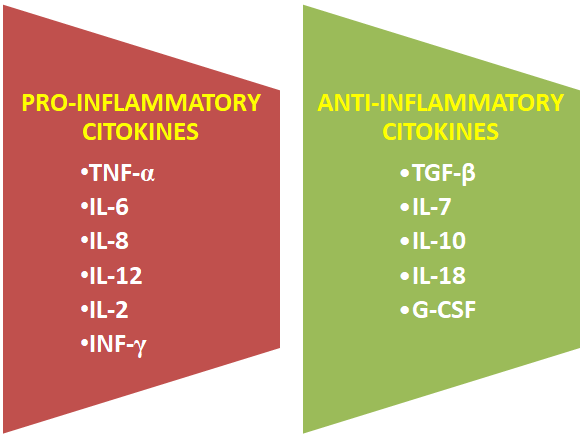
Figure 8. Cytokines present in human breast milk.